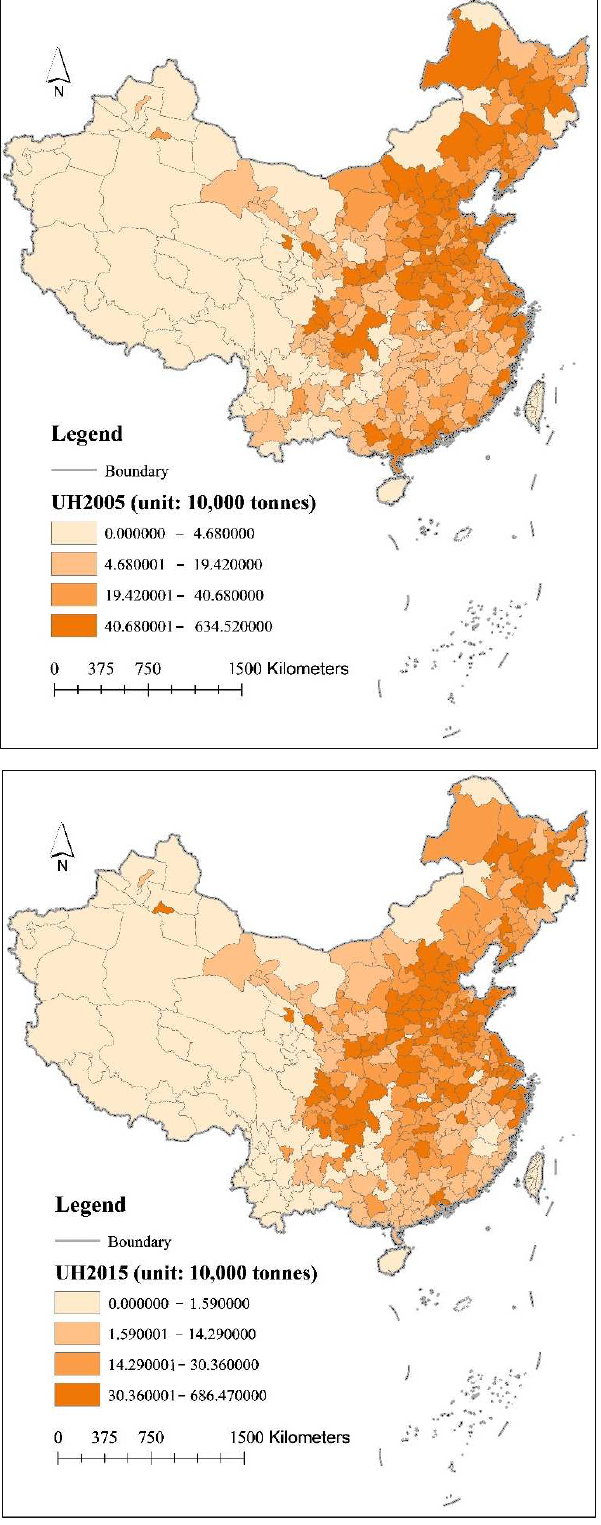
Figure 1. Spatial and Temporal Distribution of Carbon Emissions from Urban Households in China (2005–2015).